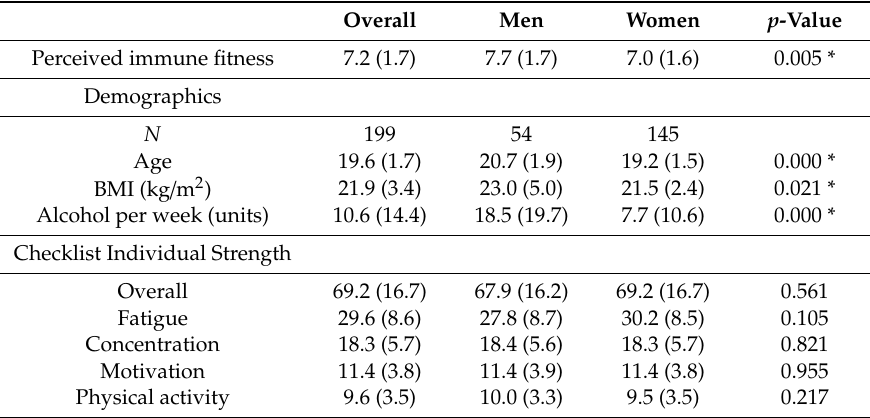
Table 1. Demographics and study outcomes.